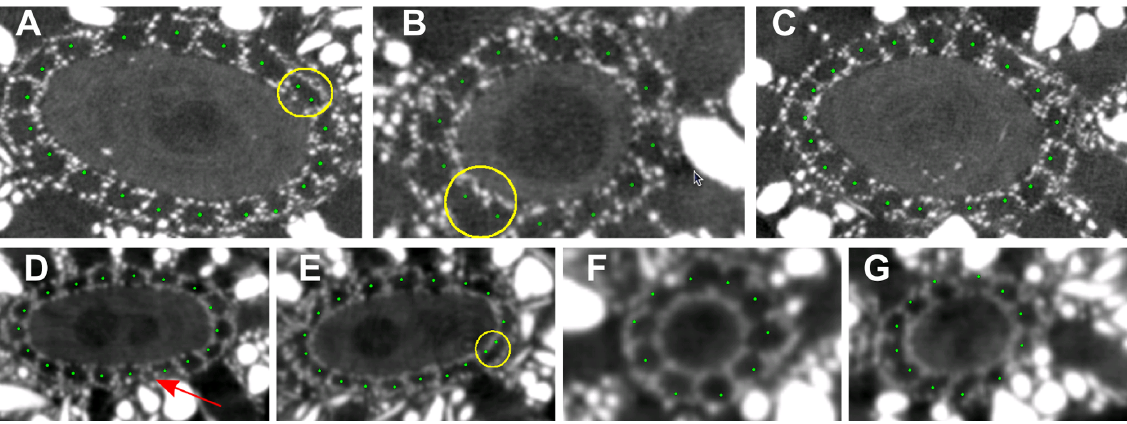
Figure 12. Automatic seed-point initialization. Results of automatic seed-point initialization in M5 (A–C) and S3 (D–G) datasets. Yellow circles highlight the canals where two seeds instead of one were placed. The arrow indicates the missed canal.